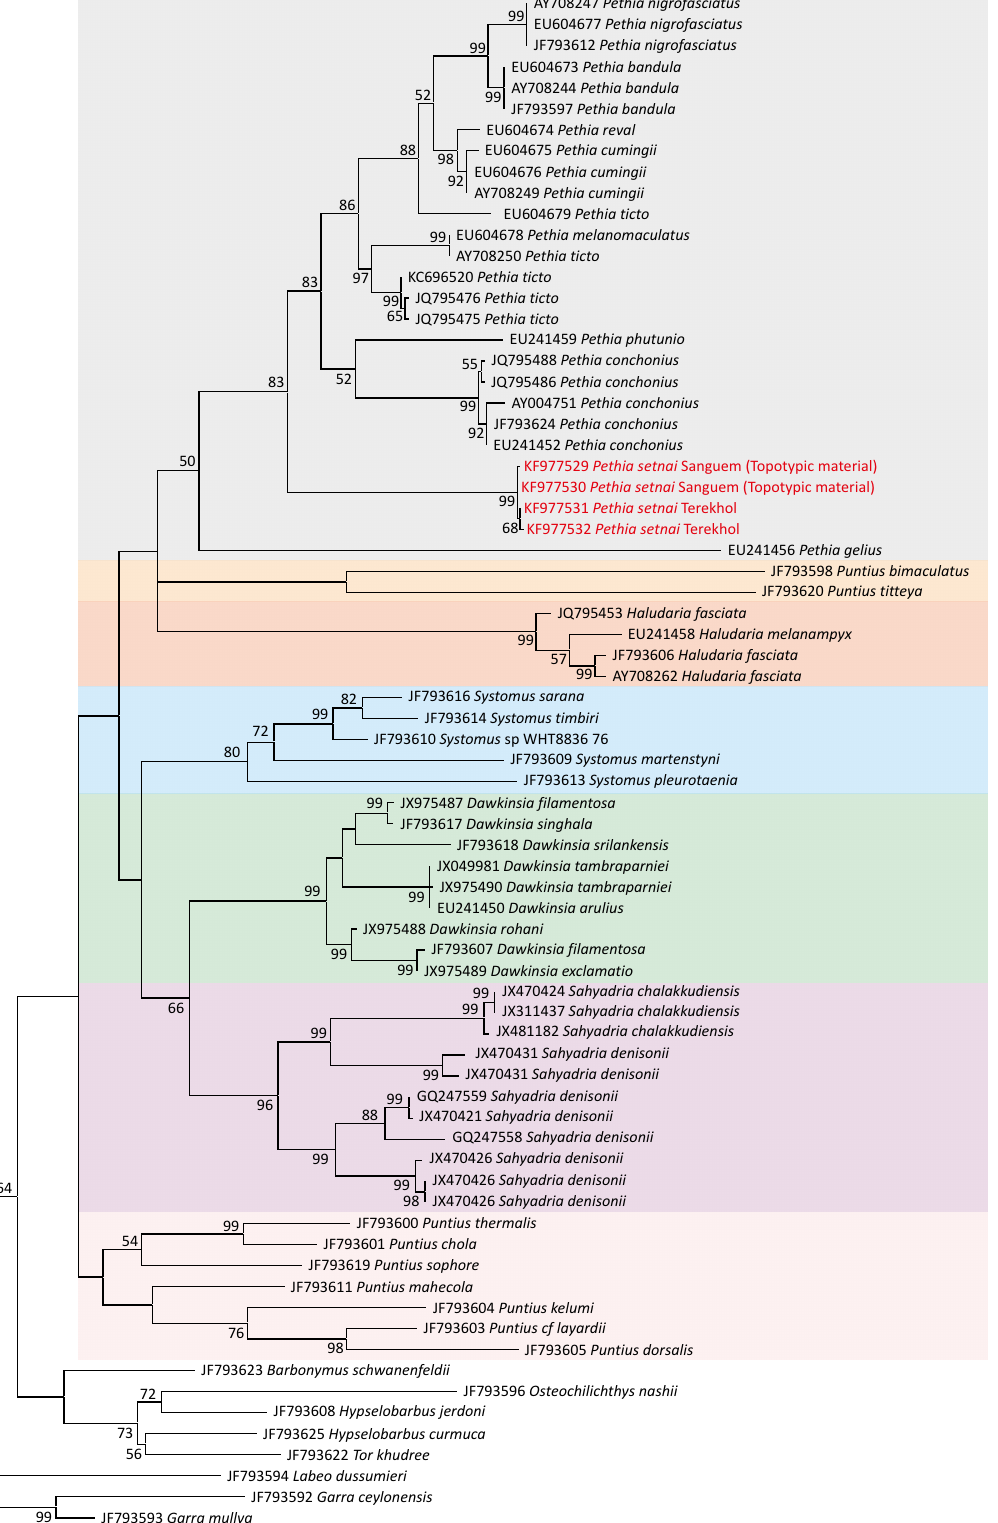
1. Phylogenetic position of Pethia setnai . Maximum likelihood tree based on mitochondrial cytb gene. Bootstrap support with more than 50% based on 1000 iterations for maximum likelihood. Garra species are used as